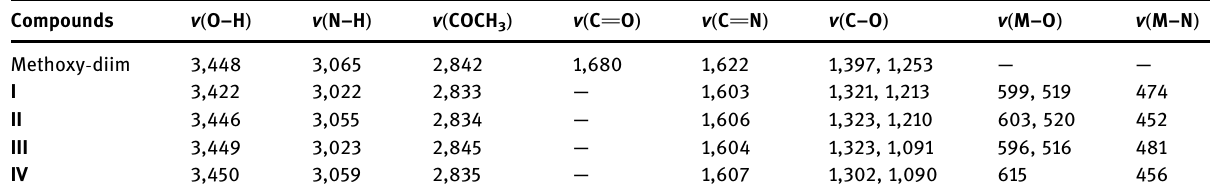
Table 2: Data for infrared spectral bands ( cm − 1 ) for the methoxy - diim ligand and its metal complexes Compounds